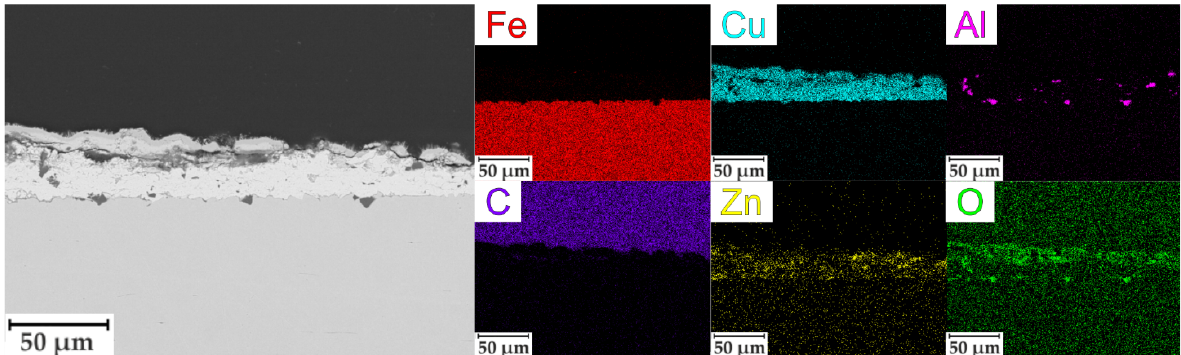
Figure 6. SEM image of the cross - section and EDX element distribution maps of SC-500 sample.